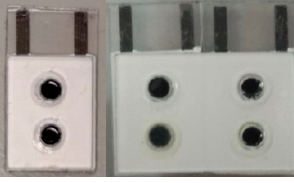
Figure 1. Combined electrodes. Left: ISE/RE setup, right: Na + , K + , Cl − ISEs/RE setup.